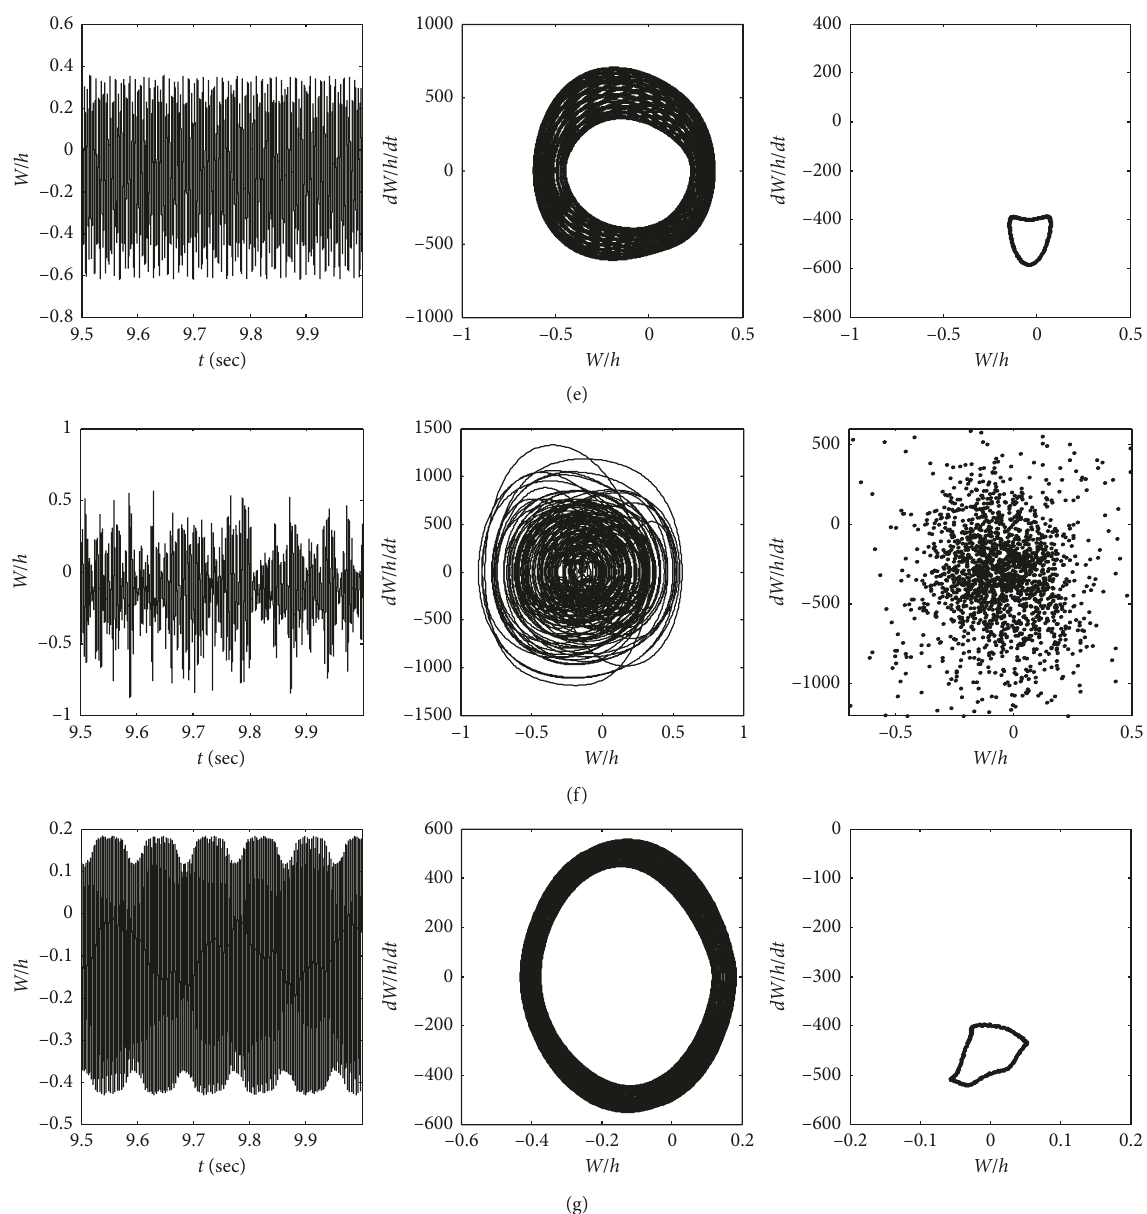
Figure 4: Time history, phase portrait, and Poincar´e maps under different dynamic pressures. (a) λ � 400. (b) λ � 900. (c) λ � 1010. (d) λ � 1040. (e) λ � 1100. (f) λ � 1150. (g) λ �